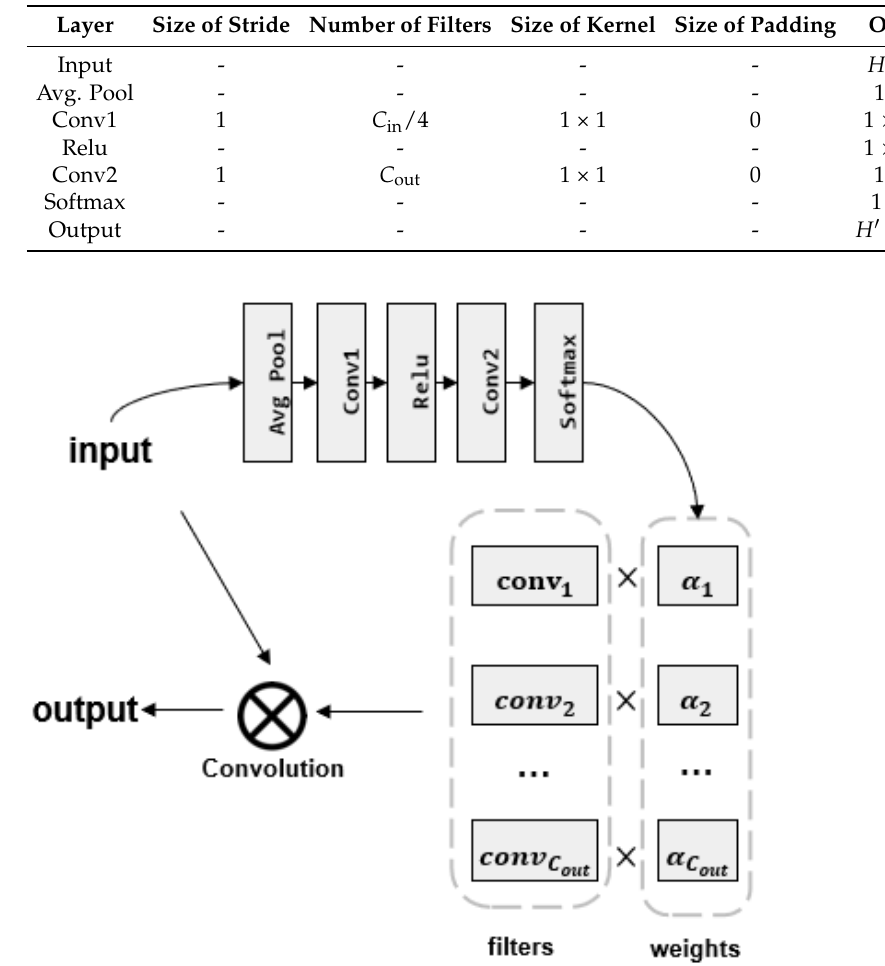
Table 2. Parameter settings for one dynamic convolutional layer.